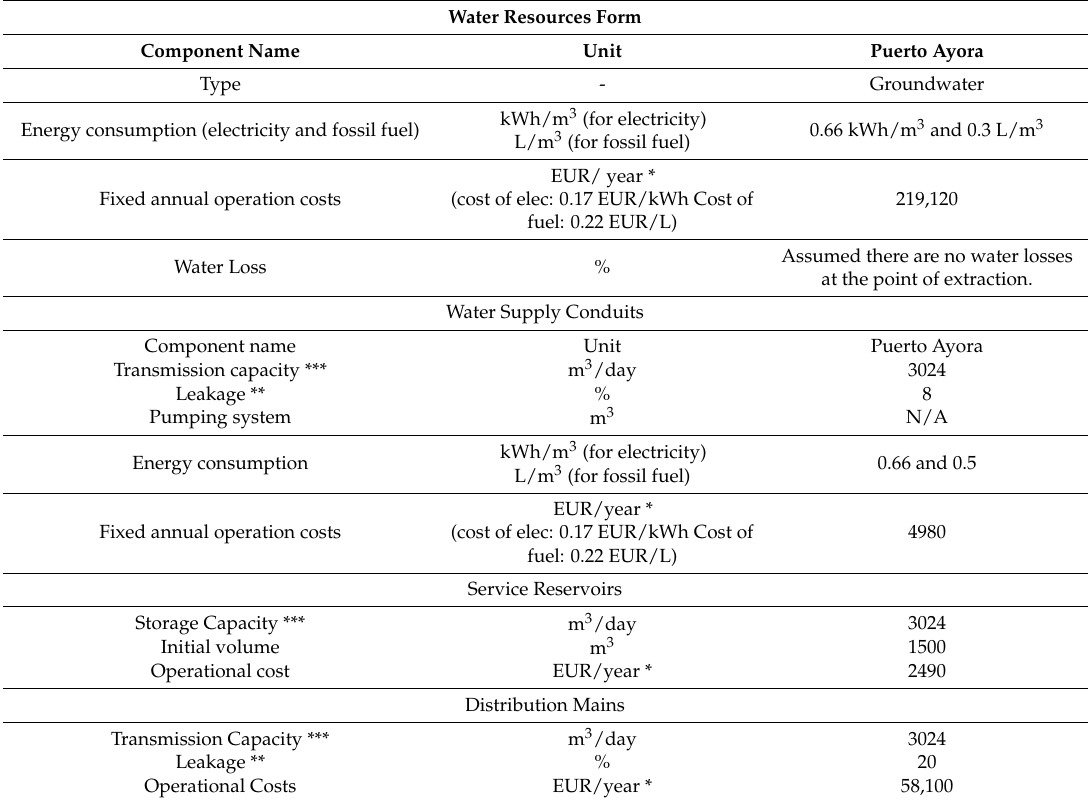
Table 2. Input information for the water supply component.